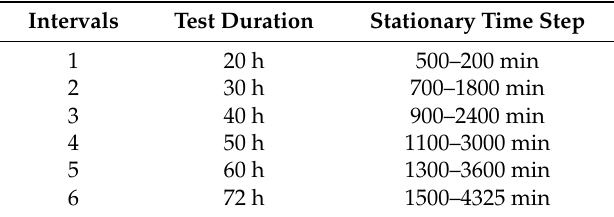
Table 2. Duration of each test interval and stationary time steps.